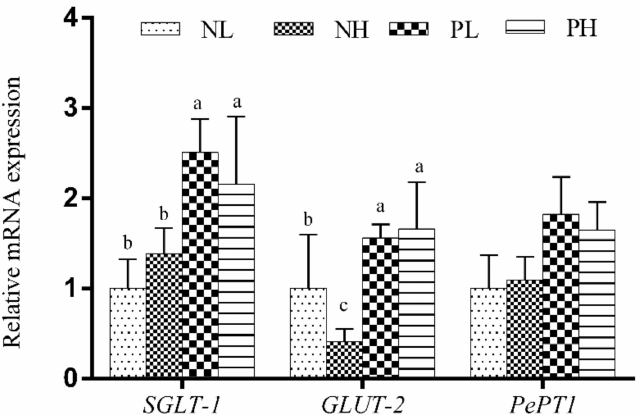
Figure 3. Effects of different moisture contents (adding 7.5 vs. 15% water) and enzyme additions (adding 4 kg/t α -amylase or not) to extruded corn on the mRNA levels of jejunal absorption-related genes in weaning piglets. Each column represents the mean expression level with six independent replications. Letters above the bars (a, b) indicate statistical significance ( p < 0.05) of genes expression among the four treatments. NL, adding 7.5% water before corn extrusion; NH, adding 15.0% water before corn extrusion; PL, adding 7.5% water and 4 kg/t α -amylase before corn extrusion; PH, adding 15% water and 4 kg/t α -amylase before corn extrusion; SGLT1 , Sodium-glucose co transporter 1; GLUT2 , Glucose transporter 2; PePT1 , Peptide transporter 1.